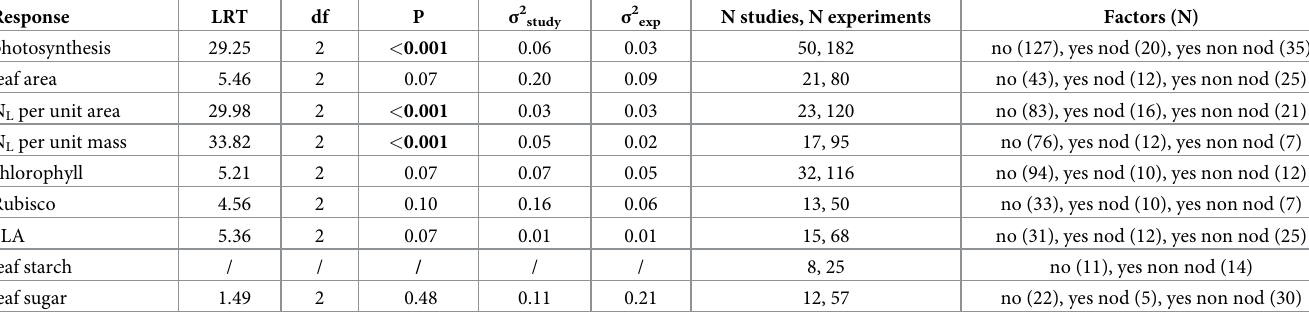
Table 4. Results of the linear mixed models for all response variables with legume status as predictor.